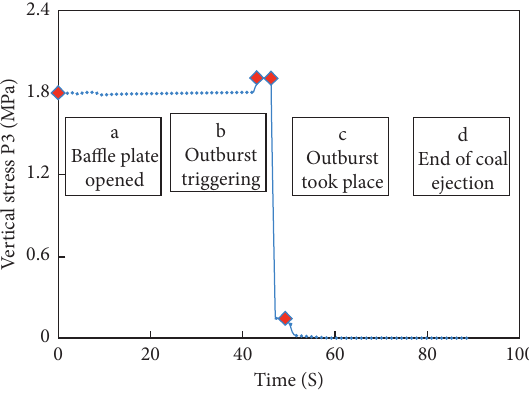
Figure 6: Variation curve of stresses loaded